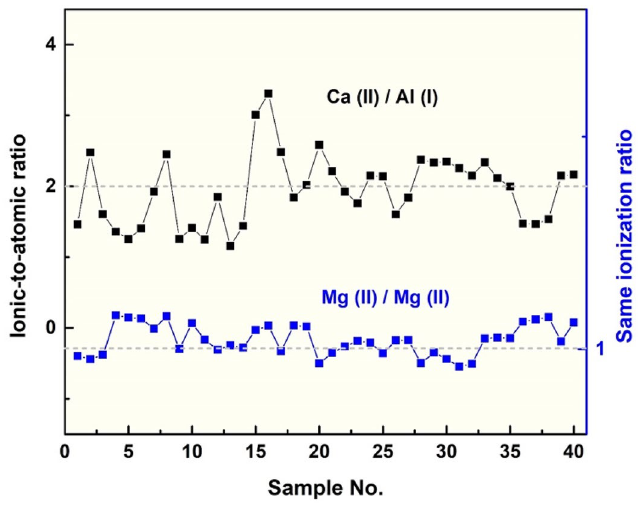
Figure 5. Relative sensitivity factors of ionic-to-atomic and ionic-to-ionic lines detected within fs-Solstice spectra proving abundant presence of ionic lines in fs